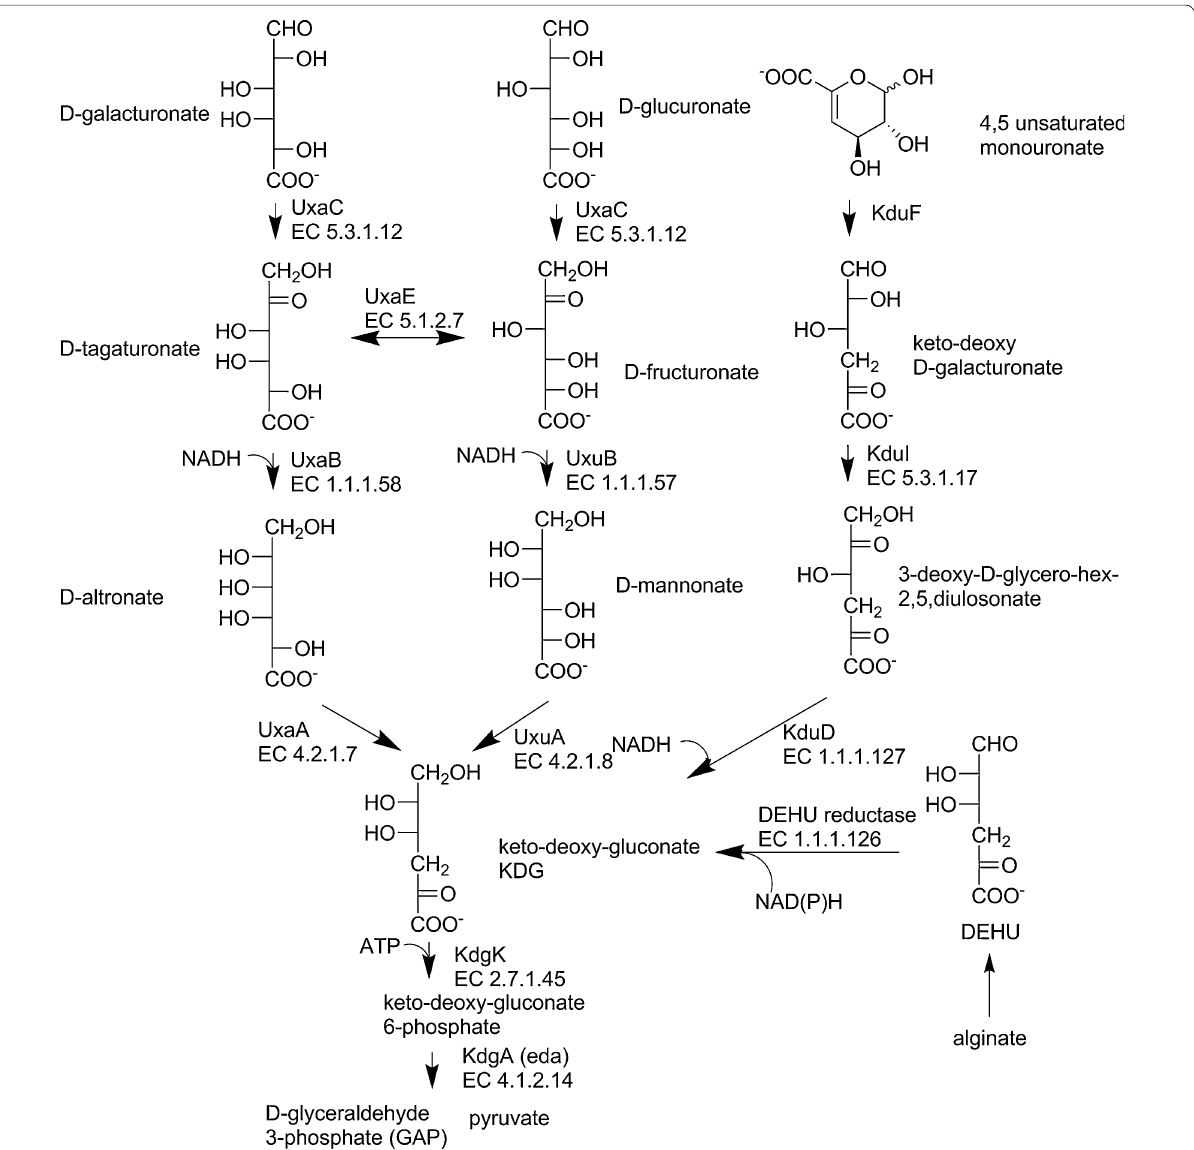
Fig. 2 Bacterial pathways for hexuronate catabolism through keto-deoxy-gluconate, KDG. The pathways for d -galacturonate and d -glucuronate have the enzymes UxaC, KdgK and KdgA in common. The 4,5 unsaturated mono-uronate is the product of lyases acting on polygalacturonate, and DEHU (4-deoxy- l -erythro-5-hexoseulose uronate) is the product of lyases acting on alginate, a copolymer of two uronates, d -mannuronate